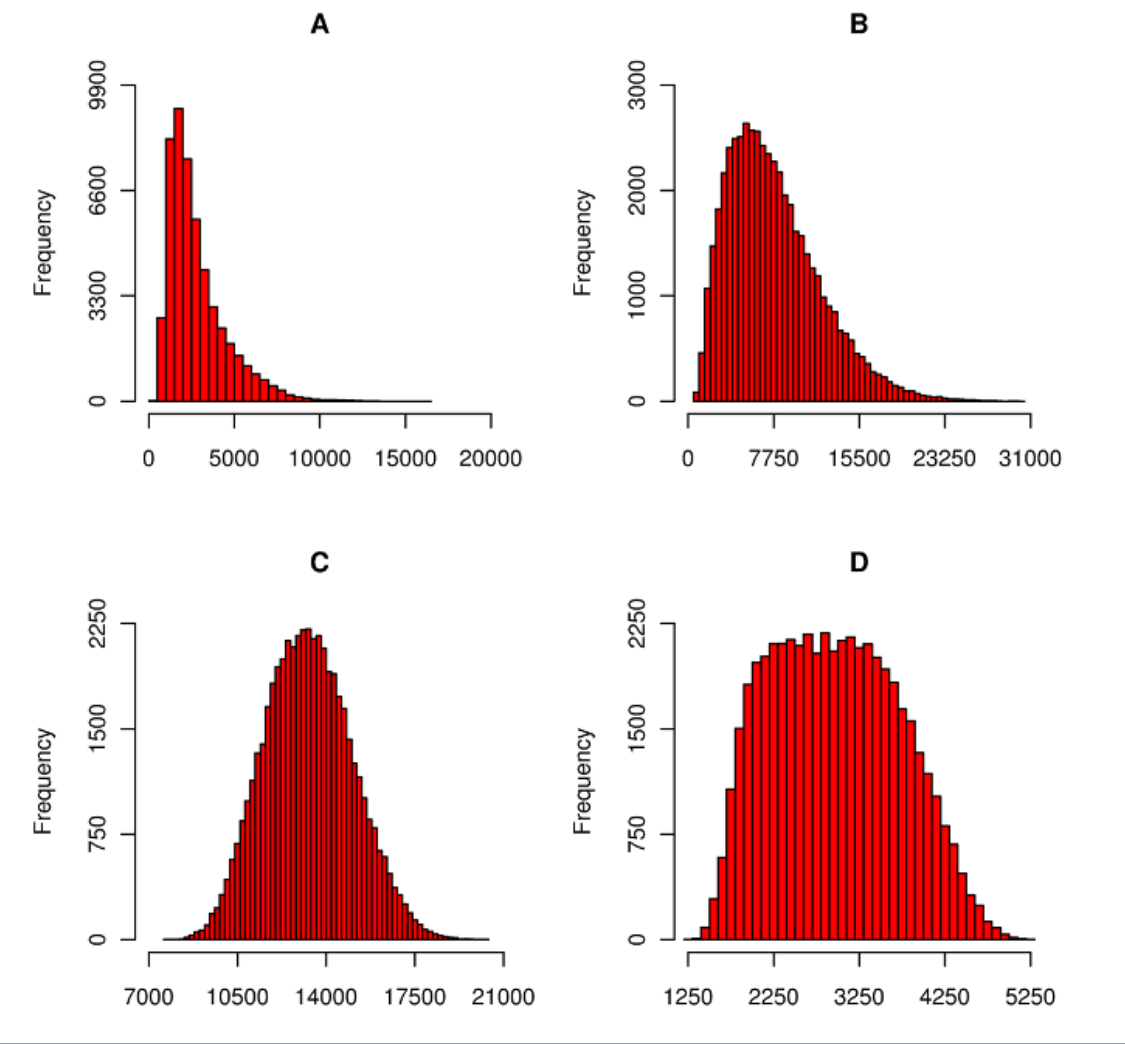
Fig. 4 . Distribution of estimated number of nests disturbed annually by A) seismic lines, B) pipeline right- of-ways, C) wells, and D) oil sands mining; note differing scale of axes. Estimates were generated from Monte Carlo simulations including estimates of annual area disturbed, proportion of disturbances occurring during the breeding season, and estimated nest densities (see